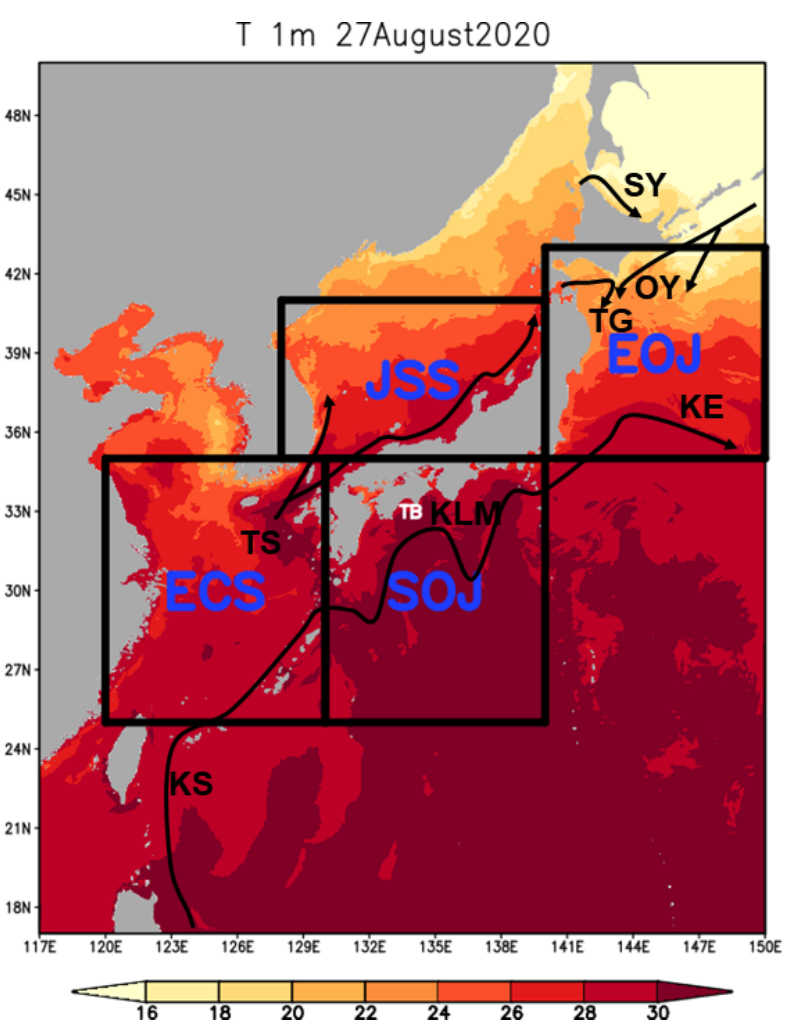
Figure 1. Daily mean SST (in °C) of the SUMM3 case (a best-case of three tuned parameters: SSTSL + SSTER + IAUSM; see Section 3.4 for more deatil) in the JCOPE-T model region on 27 August 2020. Squares denote separated regions for the skill evaluation: East China Sea (ECS), south of Japan (SOJ), east of Japan (EOJ), and the Japan Sea southern region (JSS). The location of Tosa Bay is depicted with “TB.” The black curves with arrows indicate the major ocean currents around Japan’s coasts: Kuroshio (KS), Kuroshio Extension (KE), Tsushima Current (TS), Tsugaru Current (TG), Oyashio (OY), Soya Current (SY).